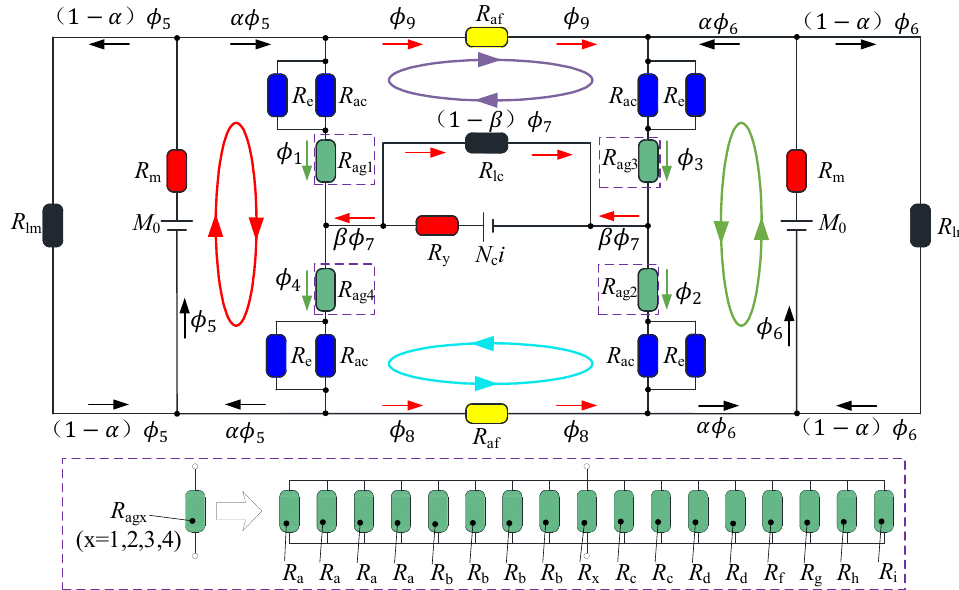
Figure 9. The equivalent magnetic circuit diagram of NLFM.